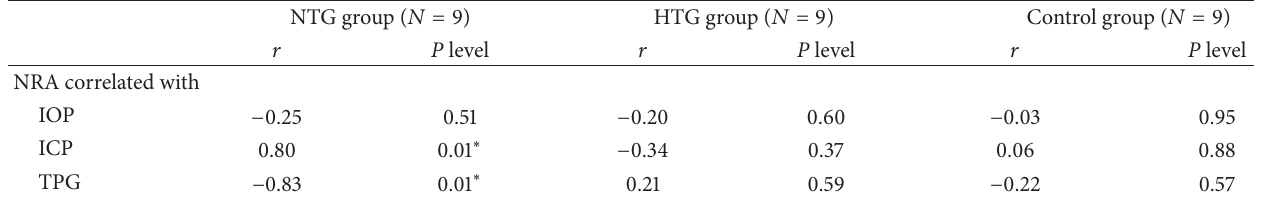
Table 3: Correlations between neuroretinal rim area and intraocular pressure, intracranial pressure, and translaminar pressure gradient in glaucoma patients and healthy